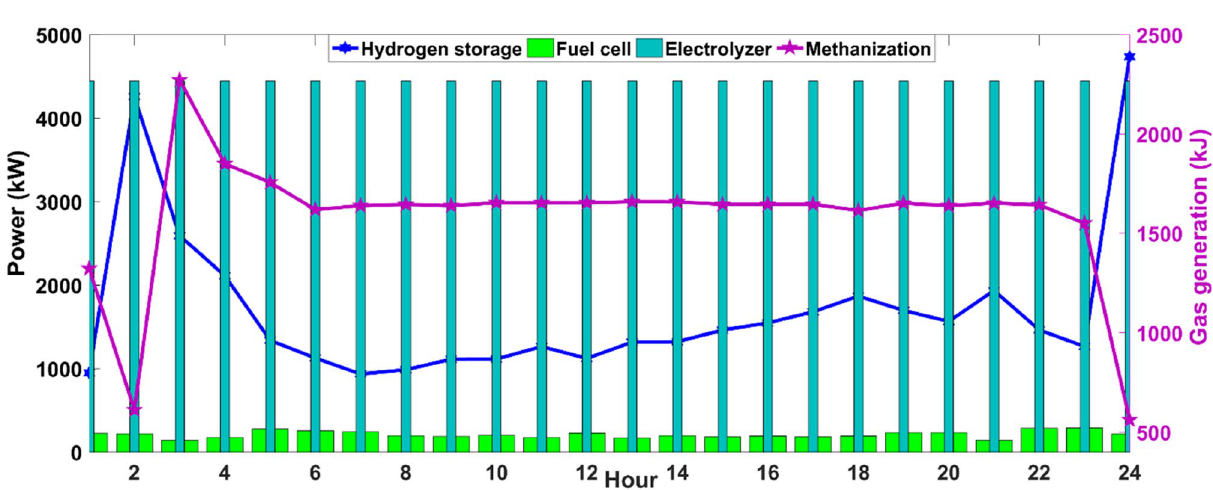
Figure 4. Optimal scheduling of the hydrogen systems. It is a clear view of how energy conversion technology can enhance the capability of operational models in making future energy grids more flexible and sustainable.